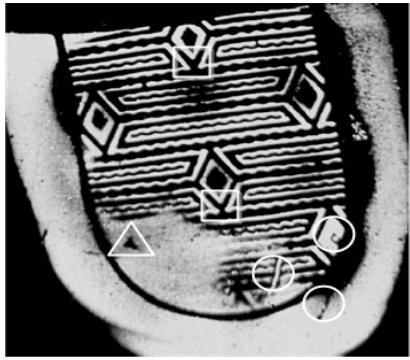
Figure 7. Examples of individual identifying characteristics. Areas labeled with circles are individual identifying characteristic with corner structure, and that labeled with triangles are individual identifying characteristics with blob ‐ like structure. Areas labeled with rectangles are shoe patterns.